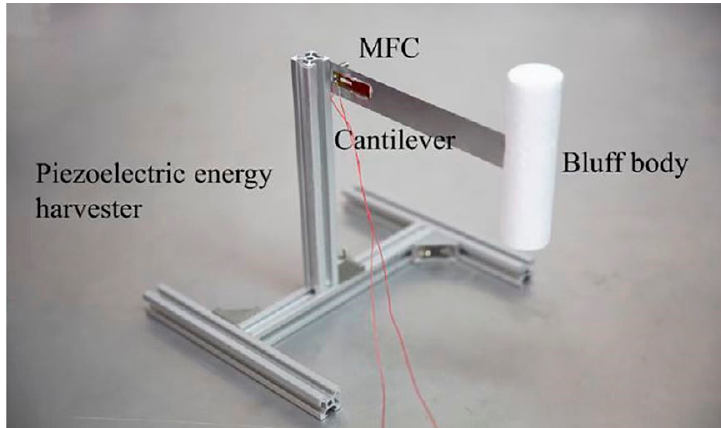
Figure 2. Physical prototype of a conventional 1DOF VIVPEH [15].